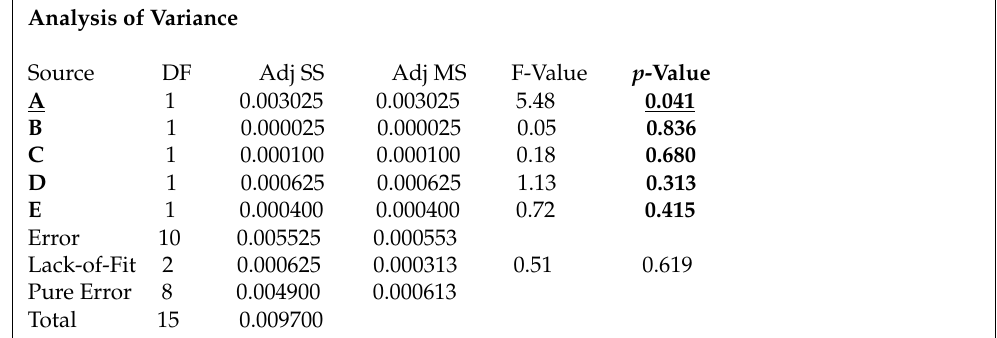
Table 8. Analysis of variance table for the ruggedness of the method. Analysis of